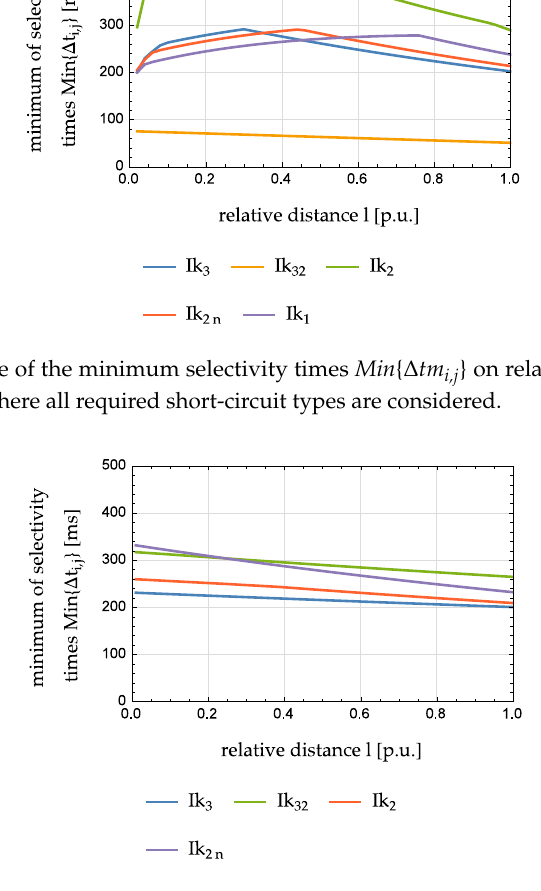
Figure 15. Dependence of the minimum selectivity times Min { ∆ tm i,j } on relative distance l for radial power system where all required short-circuit types are considered. 8. Conclusions In this paper, a new approach to coordination of the directional overcurrent protections with inverse-time characteristics in radial and distributed generation systems has been presented. Unlike other published articles on a similar topic, not just some, but all the required types of short-circuits have been taken into account. Since the coordination of taking into account a greater number of required short-circuit types can be a complex problem, a new algorithm based on the search for the most sensitive short-circuit type has been designed. To speed up the entire process, an automatic coordination algorithm based on the appropriately designed optimization has been used. By the combination of both the aforementioned algorithms, an example of protection coordination in a distributed generation system (IEEE 6-bus power system) and a radial system without distributed generation, has been examined. To point out the necessity of considering all the required short-circuit types, the coordinations have been performed for two cases. In the first case, the coordinations considering only three-phase-to-earth short-circuits and, in the second, the coordinations considering all the required short-circuit types have been performed. To verify the correctness of proposed algorithms, selectivity values have been checked along the entire protected section for all the required short-circuit types. Considering all of the required short-circuit types has been found to be very